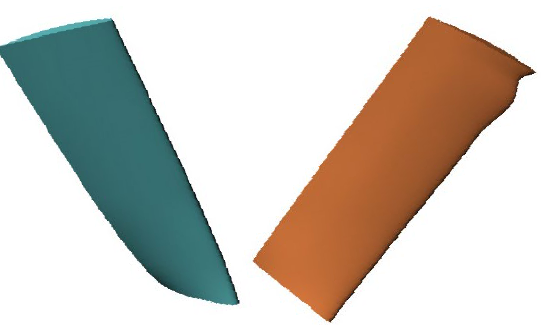
Figure 3. Datum ( left ) and whale ( right ) fan geometries.